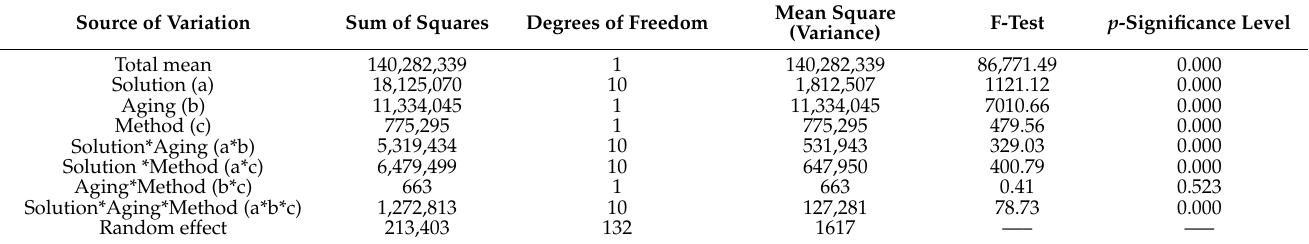
Table 3. ANOVA table for three-way analysis of the average degree of polymerization (DP) for the examined cellulose samples influenced by three factors (solution, aging, method) at 15 levels (11 different salt solutions, two types of aging, i.e., unaged and aged samples, two methods of CTC preparation) and their four combined interactions.